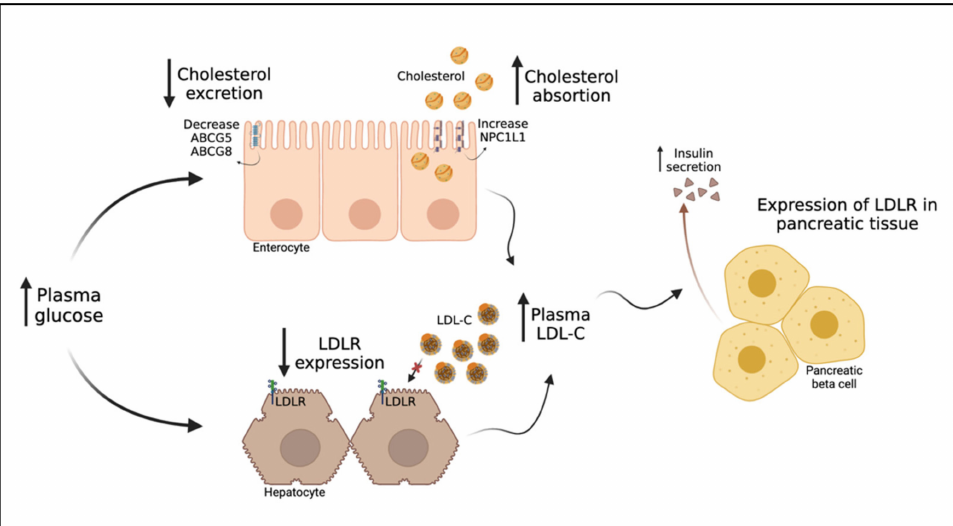
Figure 3. Effect of increased glucose on LDL-C metabolism and insulin secretion. In enterocytes, the increase in plasma glucose causes a decrease in cholesterol excretion consecutive to the reduction in the expression of ABCG5 and ABCG8. On the other hand, there is an increase in cholesterol absorption as a result of the high expression of NPC1L1. Both mechanisms contribute to raised plasma LDL-C levels. The increase in plasma glucose also reduces expression of LDLR in hepatocytes, another mechanistic pathway contributing to the increased plasma concentration of LDL-C. Such elevated plasma LDL-C levels together with the high expression of LDLR in pancreatic beta cells stimulate insulin secretion [2]. LDLR: LDL receptor, ABCG5/8: ATP Binding Cassette Subfamily G Member 5/ABCG8: ATP Binding Cassette Subfamily G Member 8, NPC1L1: Niemann–Pick C1-like 1 protein, LDL-C: LDL